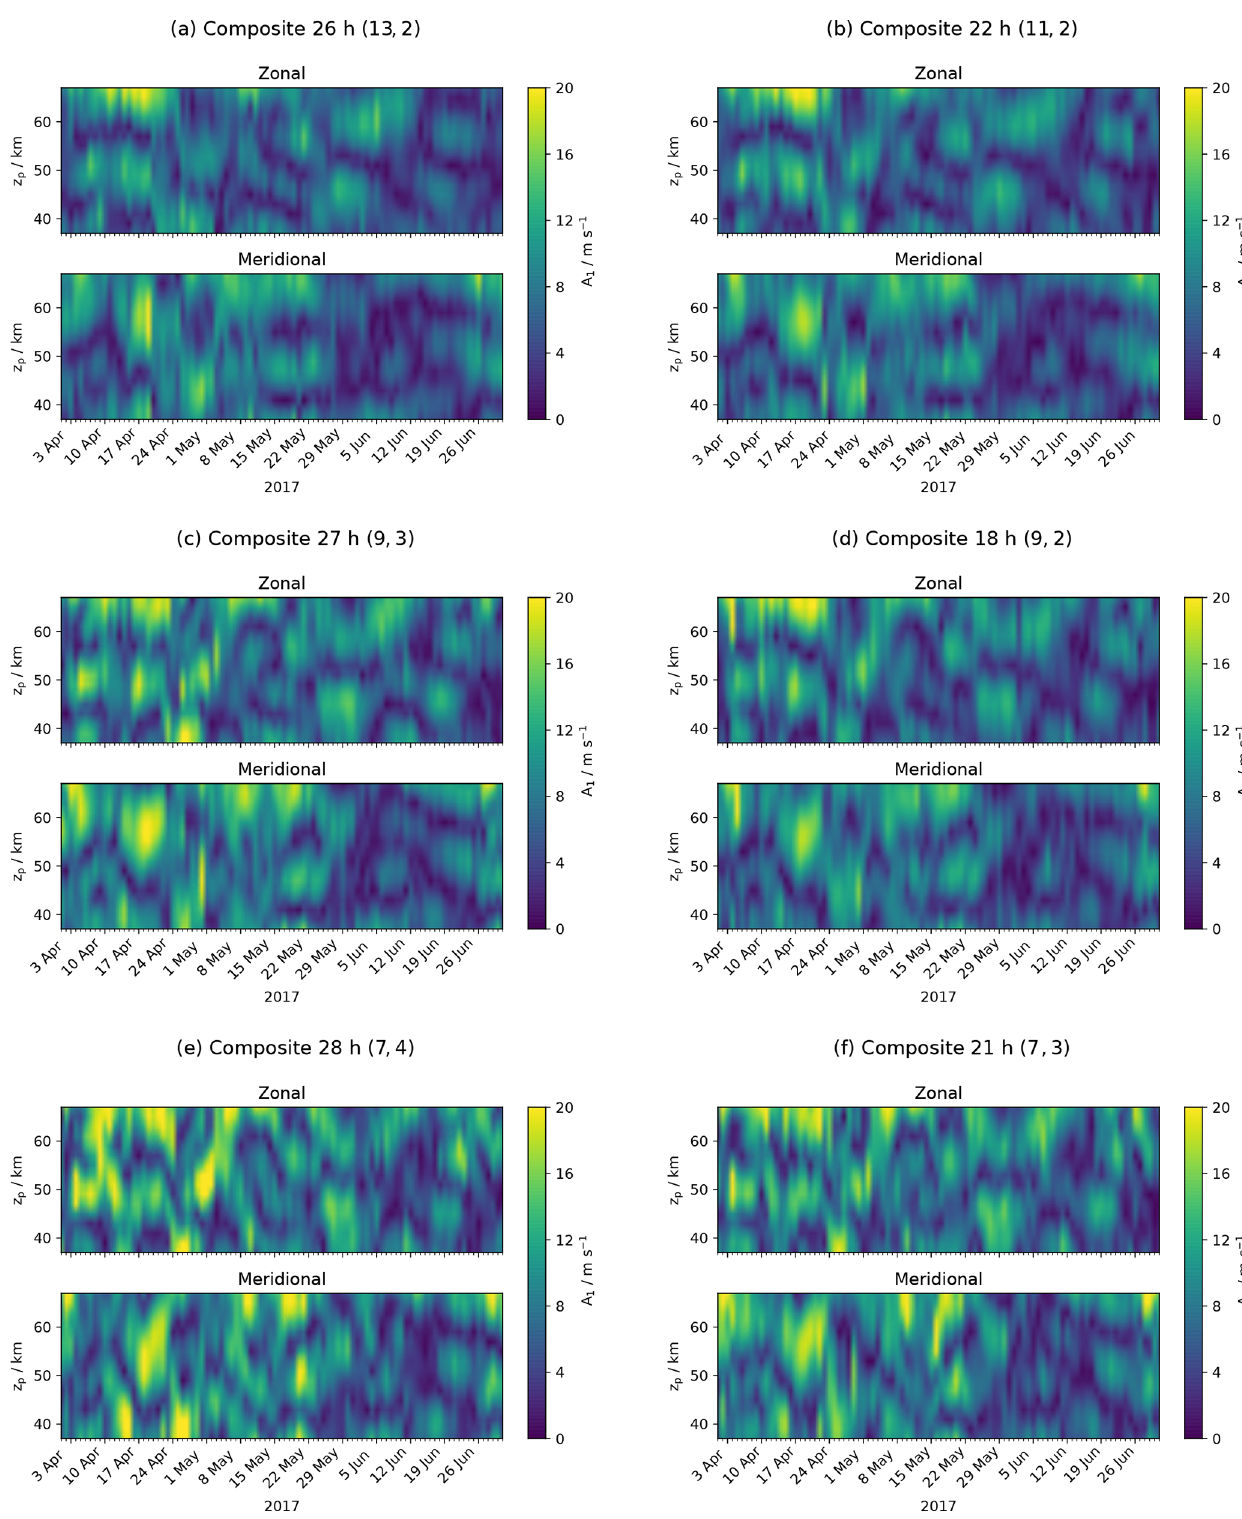
Figure A1. Tropical campaign: amplitude of the diurnal tide for six different composites with a similar total integration time of 21 to 28h ordered by window